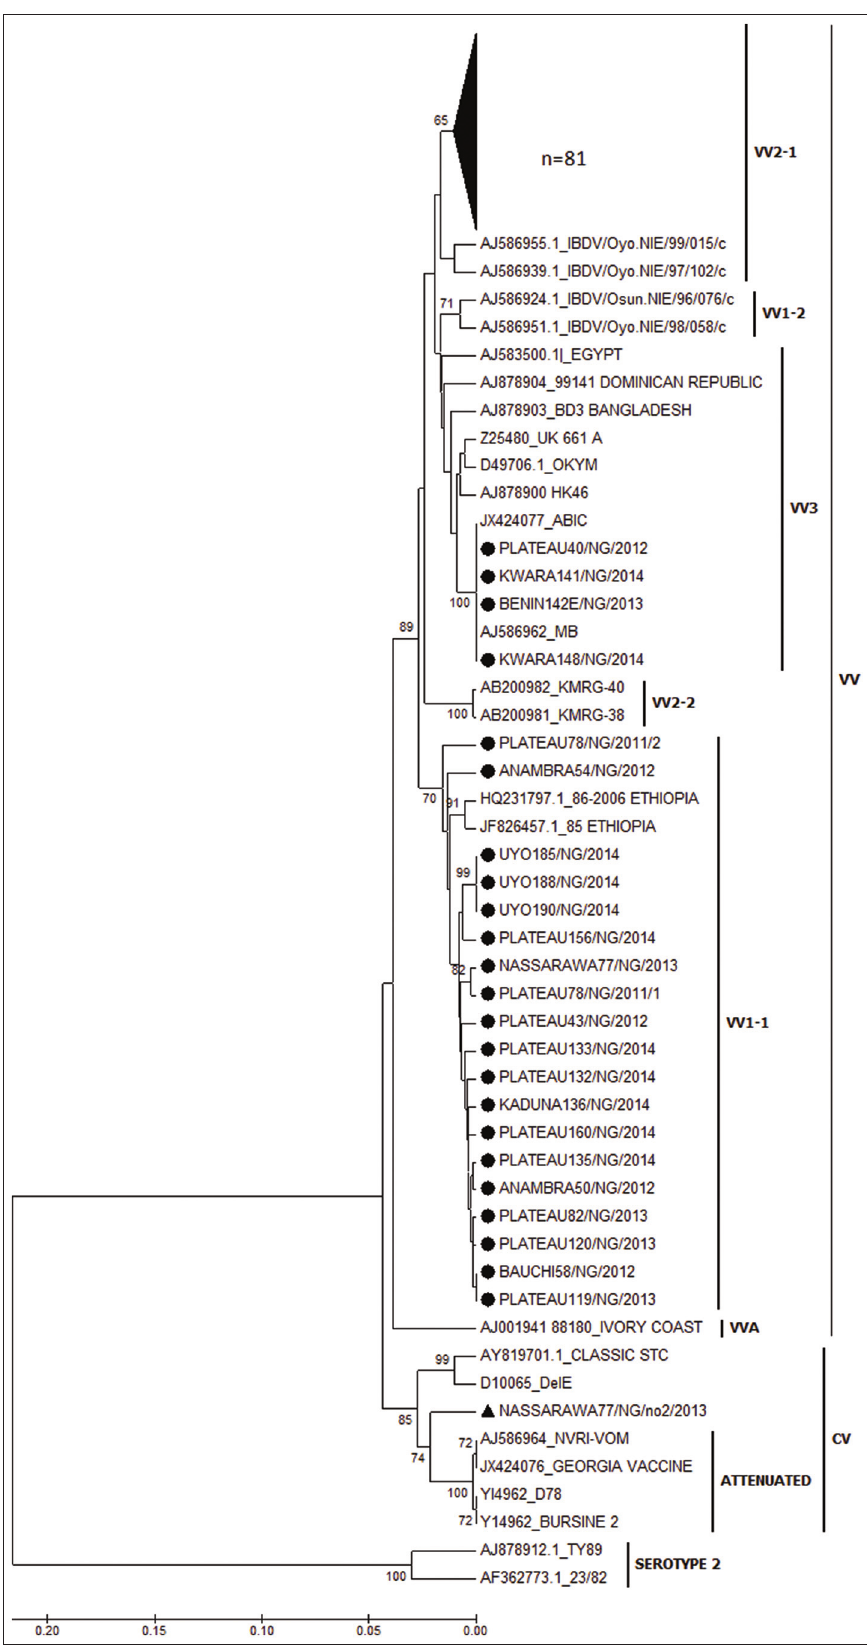
Figure-3: Phylogenetic analysis of Nigerian infectious bursal disease virus (IBDVs) and other IBDV strains from Genbank using unweighted pair-group methods using arithmetic averages with 1000 bootstrap replication. mutations. These clusters provide clues to the evolution acids are identical, they would be expected to have sim- and spread of IBDV in Nigeria, but since their amino ilar antigenic